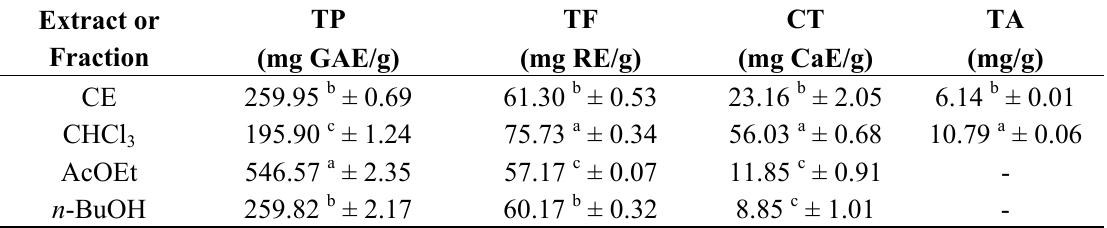
Table 1. Total polyphenols (TP), total flavonoids (TF), condensed tannins (CT) and total alkaloids (TA) in the CE and fractions from leaves of S. guaraniticum. Extract or